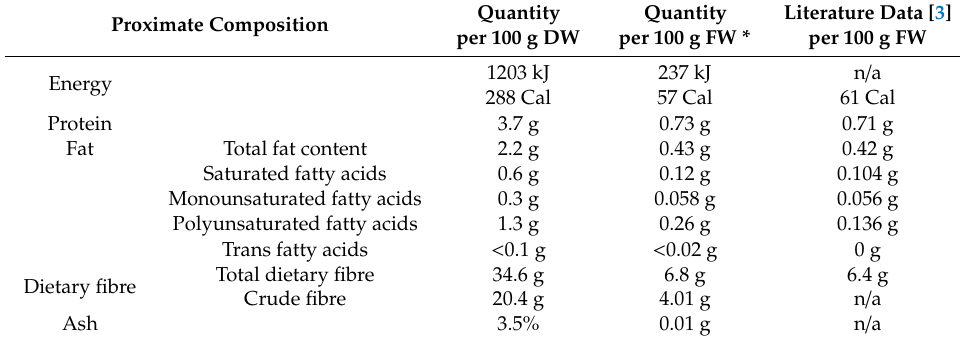
Table 2. Proximate of the feijoa whole fruit